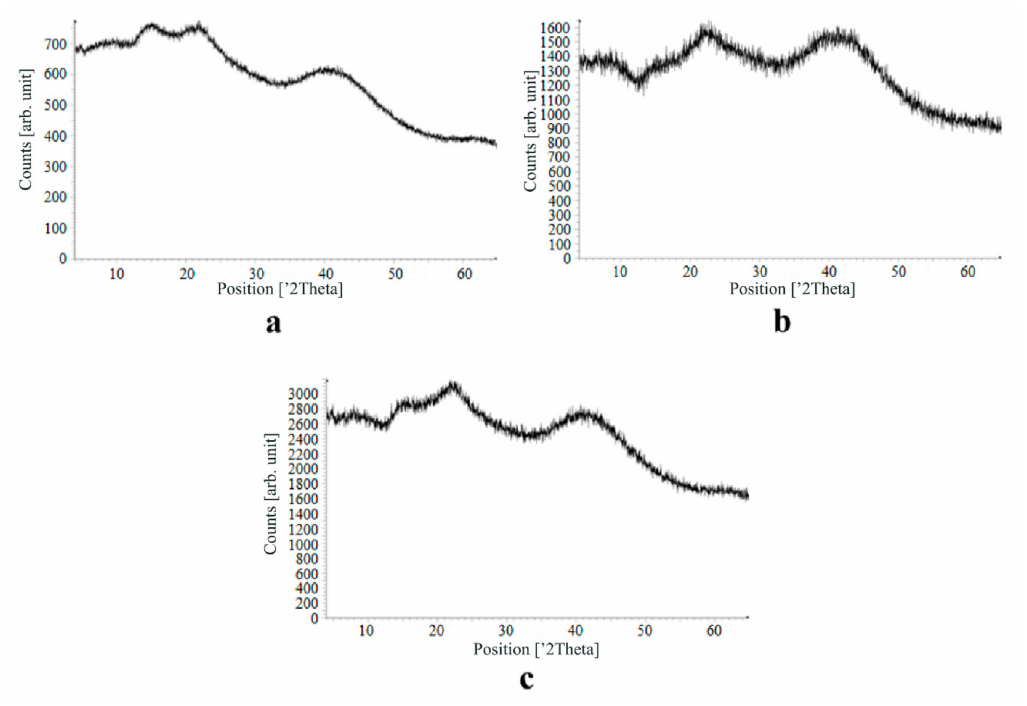
Figure 10. X-ray di ff raction patterns of loratadine loaded into the alginate-based aerogel: ( a ) 24.32, ( b ) 26.92, ( c ) 30.55 wt